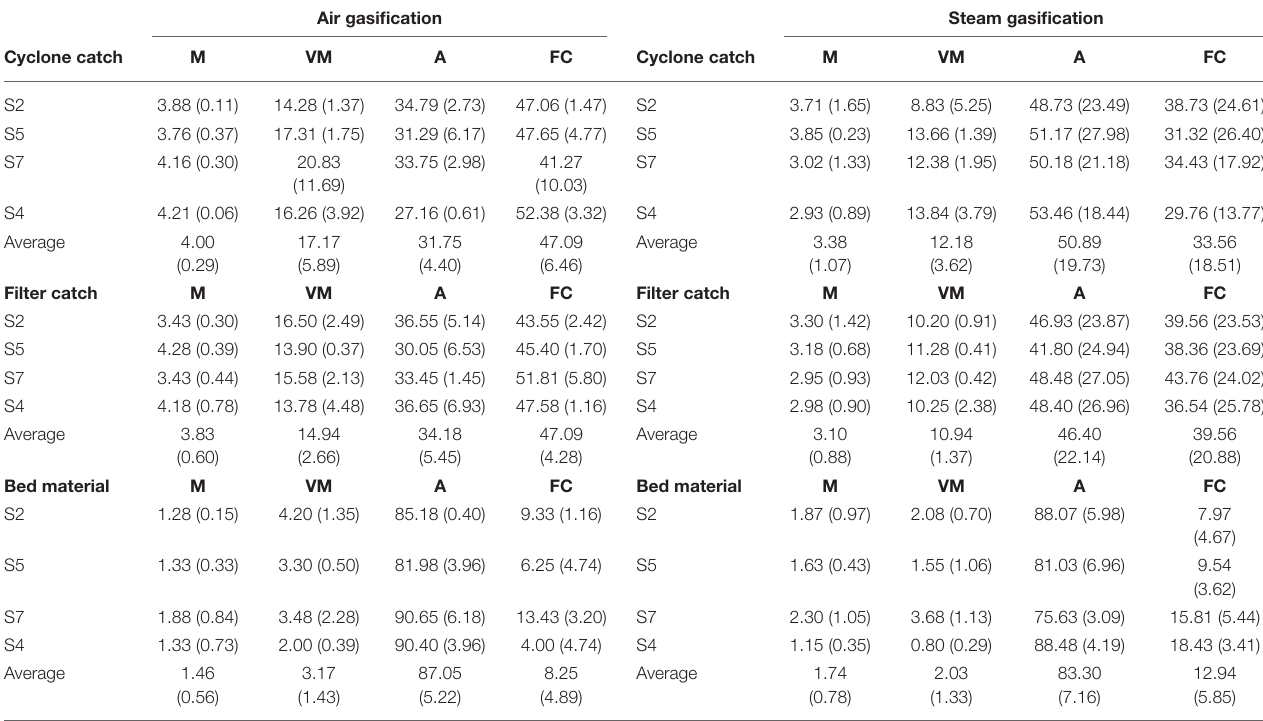
TABLE 3 | Proximate analysis [moisture (M), volatile matter (VM), ash (A), and fixed carbon (FC)] of the cyclone catch, filter catch, and bed material for the air gasification (left) and steam gasification (right) experiments. Air